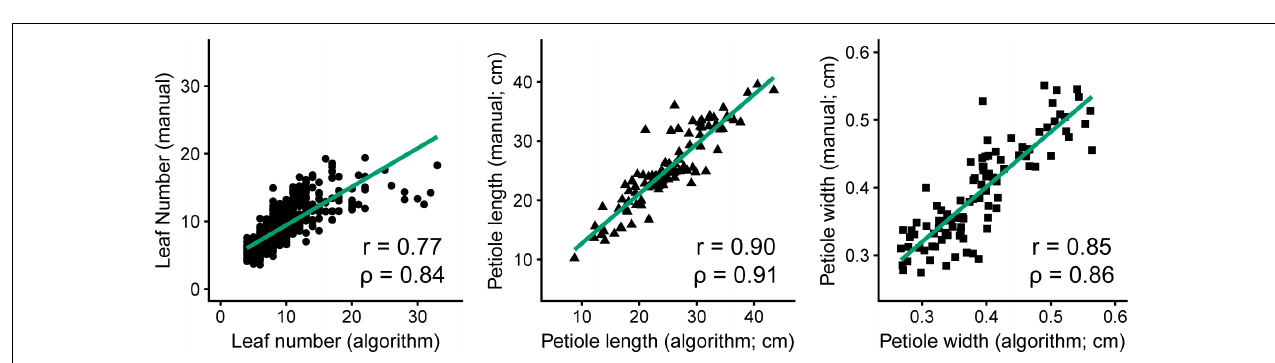
FIGURE 4 | Comparison of manual measurements to algorithm-derived values for petiole number (left, n = 910, R 2 = 0.59, P ≤ 0.001), petiole length (middle, n = 100, R 2 = 0.81, P ≤ 0.001), and petiole width (right, n = 100, R 2 = 0.72, P ≤ 0.001).